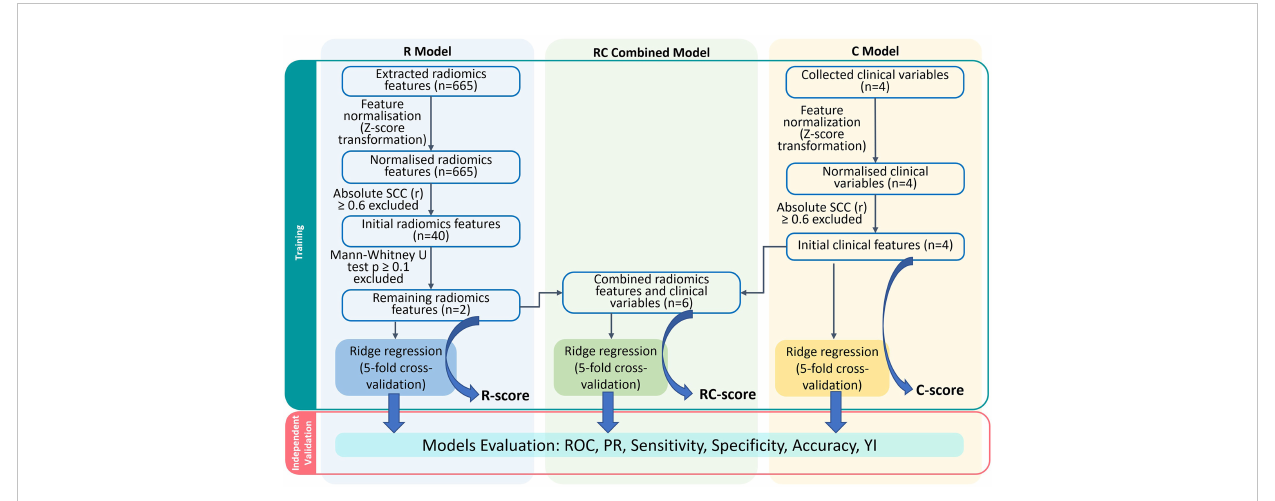
FIGURE 3 Models construction work fl ow. R, Radiomics; RC, Radiomic-clinical; C, clinical; n denotes number of features; ROC, receiver-operating characteristic; PR, precision-recall; YI, Youden